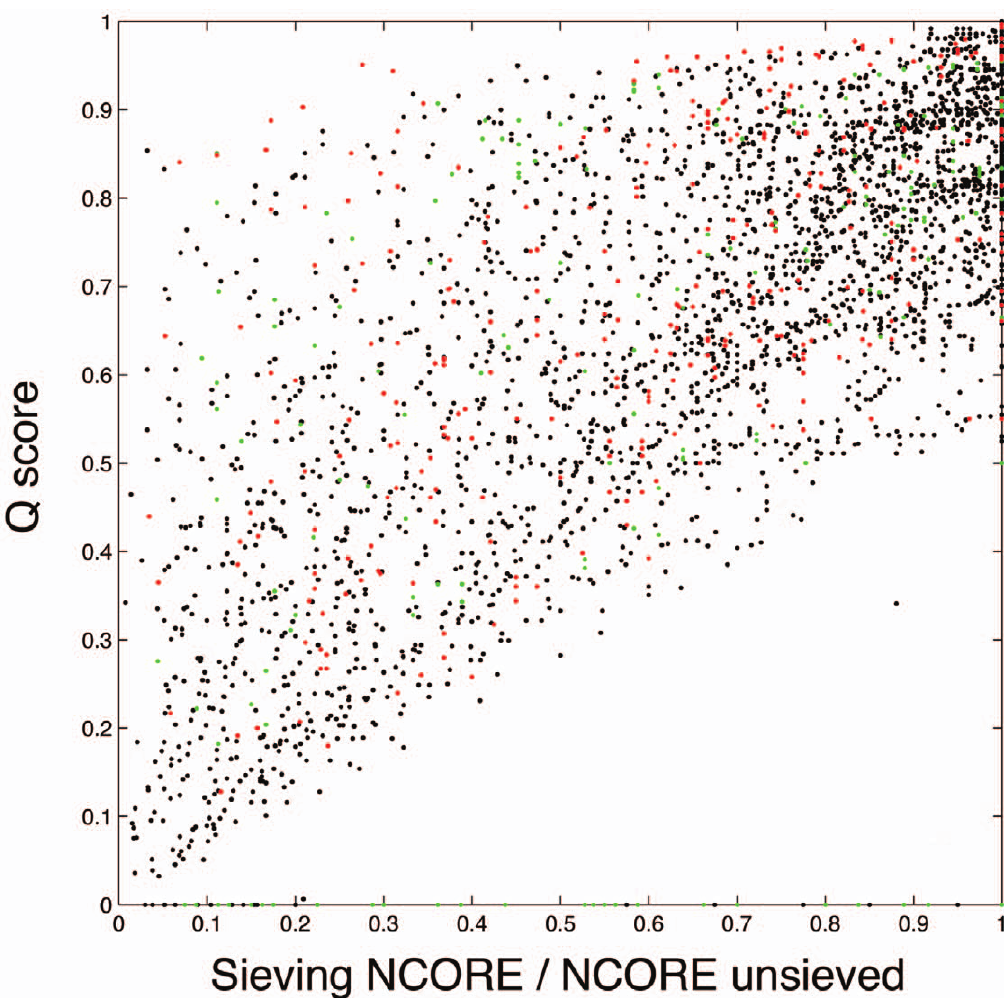
Figure 4. Performance of ‘sieving’ against manually curated alignments from SISYPHUS [8]. Q scores were computed using the program QSCORE. Colors correspond to the 3 category groups in the SISYPHUS database: Homologous (black), Fold (green) and Fragments (red). We did not observe any clear relationship between Q scores, sieving level and the three classes.